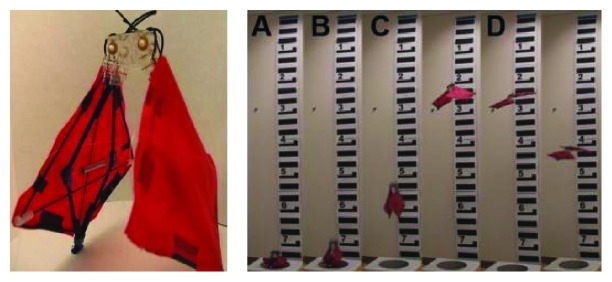
Jumping and gliding robot [73].